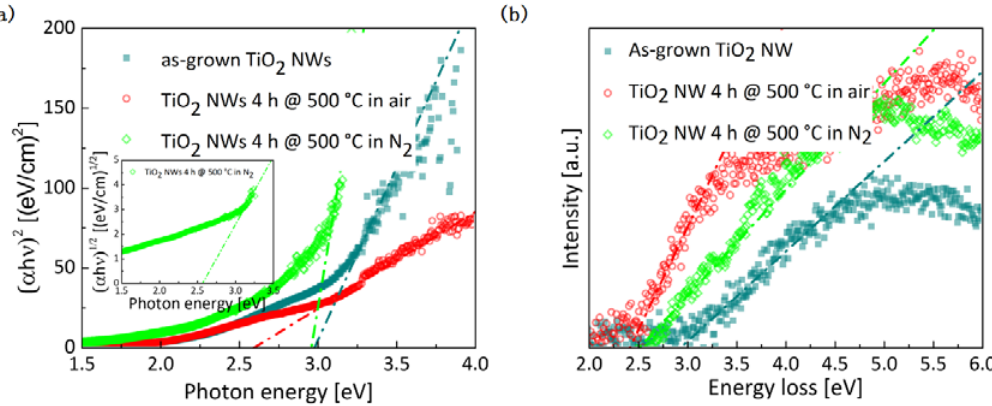
Figure 5. ( a ) Tauc plot for direct band gap and ( b ) zero-loss subtracted low-loss EEL spectra for NWs which are as-grown (petrol squares), annealed in air (red circles), and annealed in N 2 (green